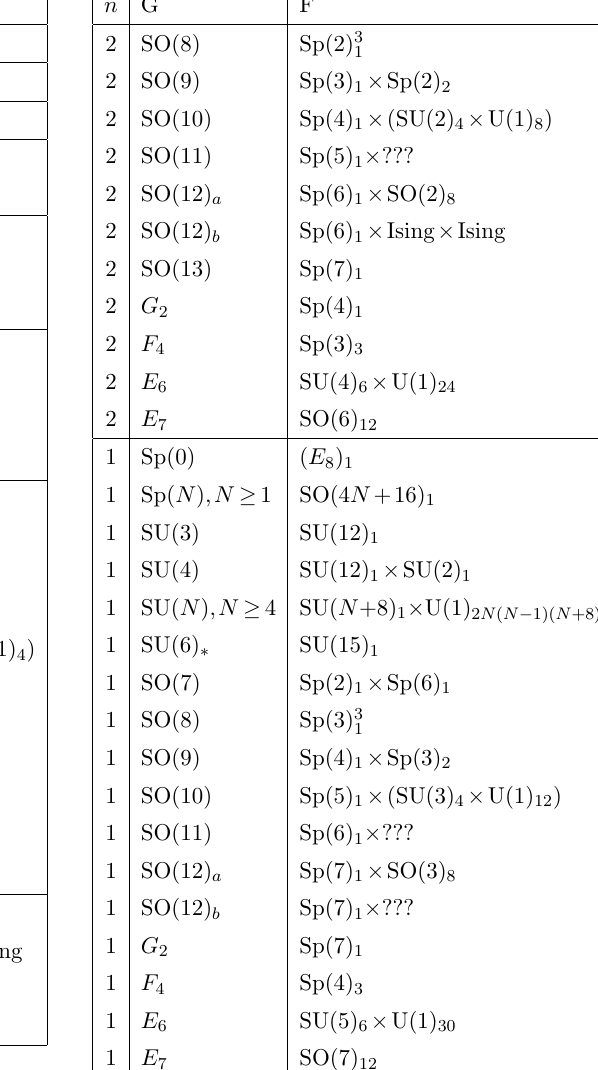
Table 1. Current algebra associated to the (cid:13)avor symmetry F of the n indicate cases for which we do not have a good understanding of the worldsheet realization of the (cid:13)avor symmetry. The notation SO(12) a;b and SU(6) (cid:3) is explained in section 2.4. speci(cid:12)c examples, we (cid:12)nd evidence that the G dependence indeed organizes itself in terms of irreducible characters of the (cid:0) n G Kac-Moody algebra, where the level k